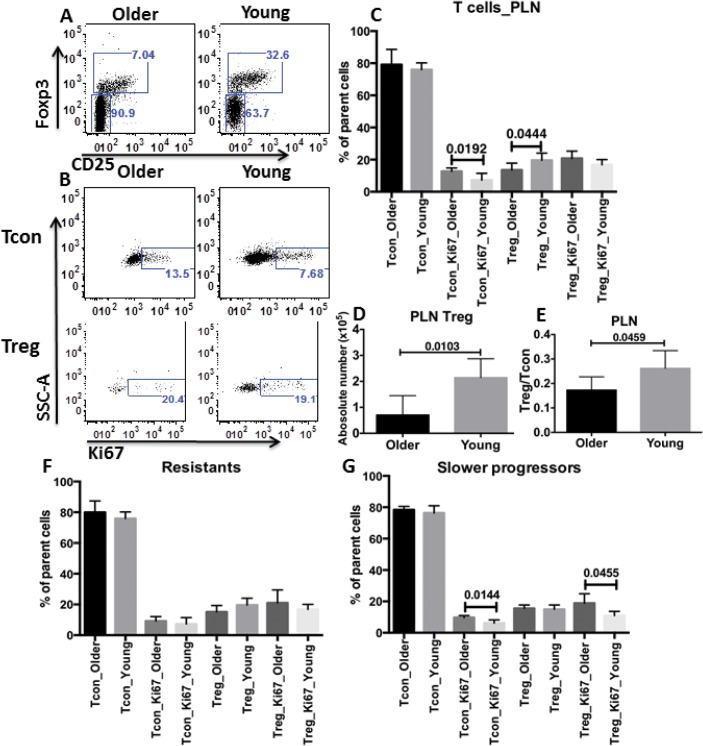
Higher abundance of Treg and lower proliferation of Tcon in PLN from young recipients.A. Representative FACS data of PLN Tcon and Treg distribution of one rapid progressor from older recipients (indicated as older) and that of one resistant from young recipients (as young). B. Representative FACS data showed the proliferation level of PLN Tcon (top panels) and Treg (bottom panels) of one older rapid progressor (indicated as older) and one young resistant (as young). C. Statistical analyses of the percentage and proliferation of PLN Tcon and Treg from older rapid progressors (as older, n = 6) vs. young resistants (as young, n = 5). D. Statistical analyses of the absolute number of PLN Treg in older rapid progressors (as older) vs. young resistants (as young). The absolute numbers were calculated as: total PLN number (by hemo-cytometer) times percentage of Treg among total PLN cells (by FACS). E. Comparison of the ratios of percentage of Treg to percentage of Tcon in PLN between the older rapid progressors (as older) and young resistants (as young). F. The percentage and proliferation of Tcon and Treg in 3 older resistants vs. those parameters in 5 young resistants. G. The percentage and proliferation of Tcon and Treg in slower progressors that reached end-stage diabetes at 4m post-transplantation (n = 4 and 5 for young and older recipients respectively). For panels C through G, unpaired 2-tailed T test was applied for comparing values between the older rapid progressors and the young resistants (panels C to E), between the young and the older resistants (panel F) or between the young and the older 4m progressors (panel G). Only those with statistical significance or P <0.05 were labeled. “Parent cells” in panels C, F and G indicates the immediate upstream gating of the corresponding subset.